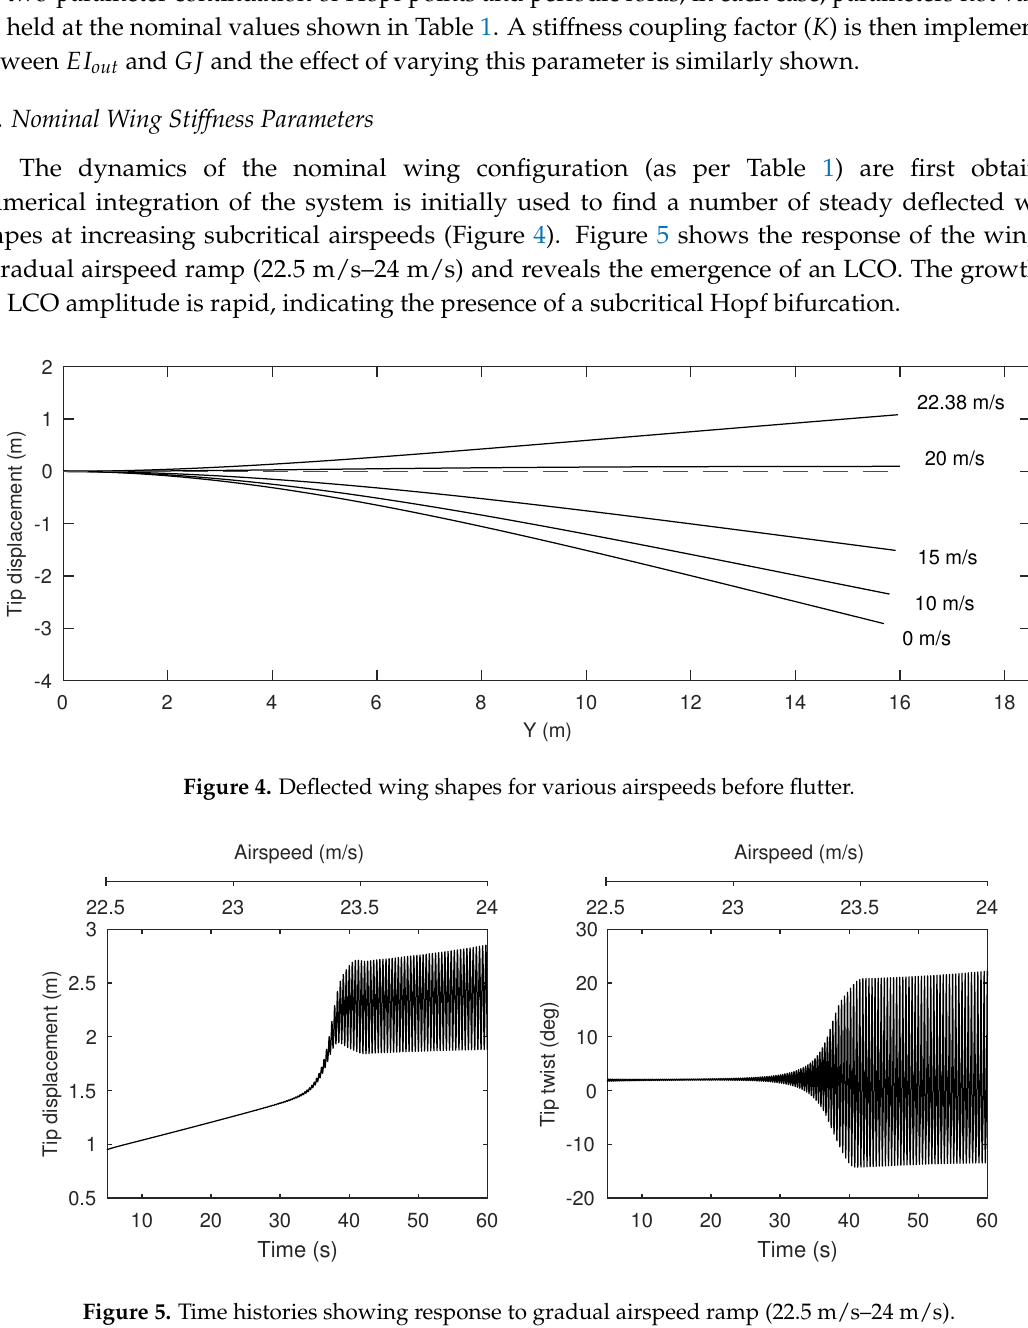
Figure 5. Time histories showing response to gradual airspeed ramp (22.5 m/s–24